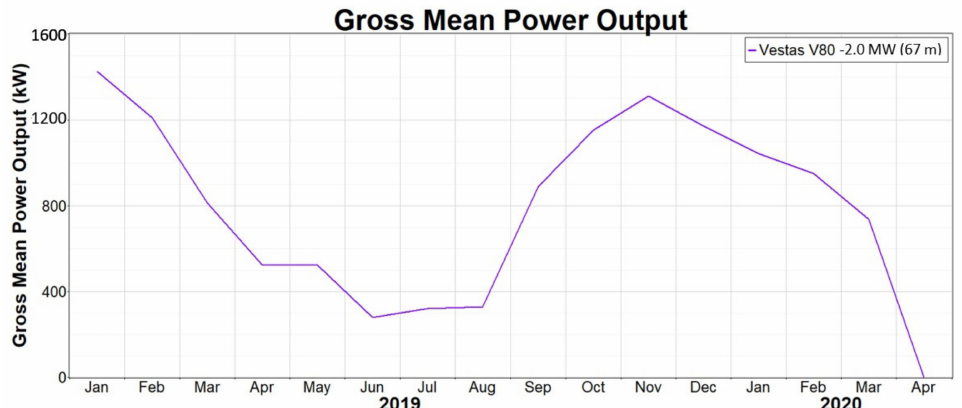
Figure 13. Gross mean power-output estimation (Vestas V80–2.0).